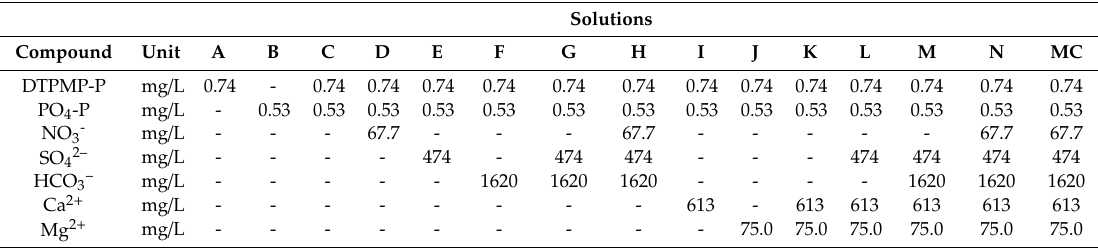
Table 1. Composition of the solutions. A-N: synthetic replicas, MC: membrane concentrate.